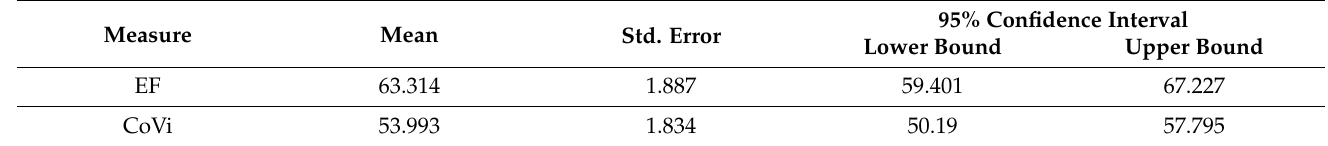
Table 5. Estimated marginal means—grand